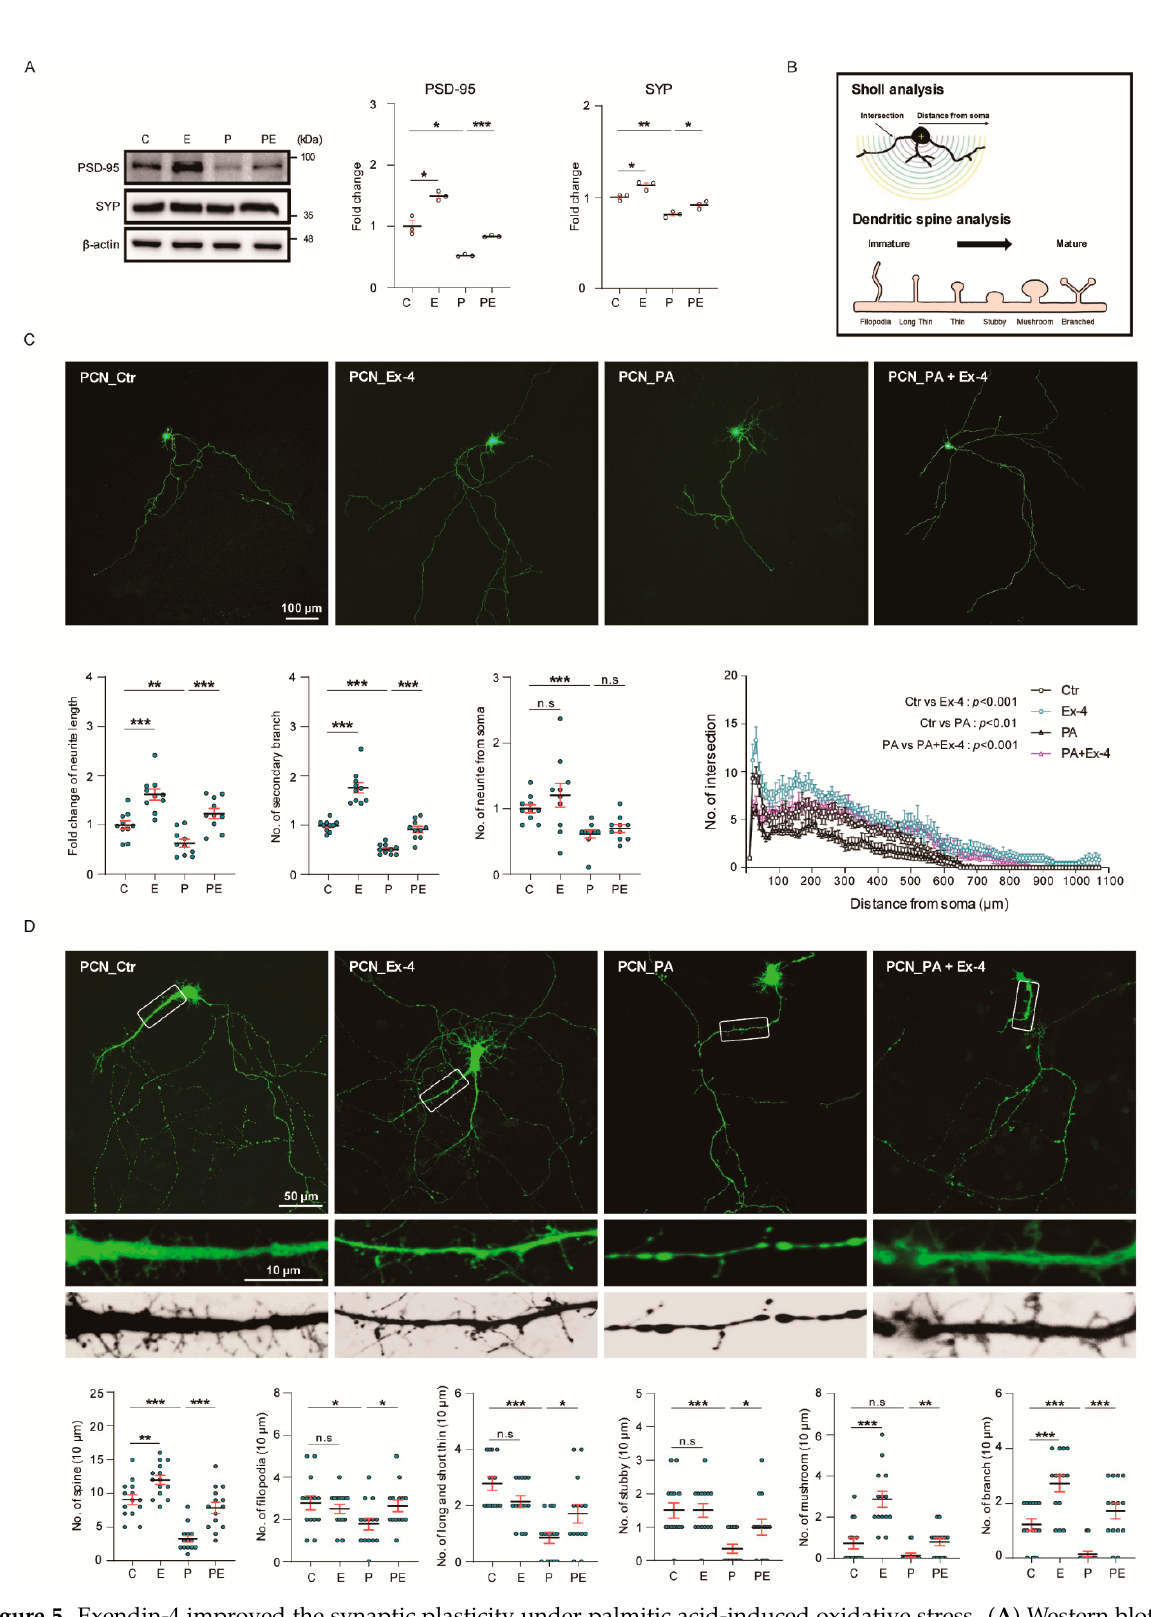
Figure 5. Exendin-4 improved the synaptic plasticity under palmitic acid-induced oxidative stress. ( A ) Western blot of synaptic plasticity-related protein in PCN at DIV21 treated with vehicle (C or Ctr), Exendin-4 (E or Ex-4), palmitic acid (P or PA), and both palmitic acid and Exendin-4 (PE or PA+Ex-4). Each protein level is normalized to β -actin. ( B ) Scheme of Sholl analysis (upper) and dendrite spine morphology analysis (lower). ( C ) Fluorescent images, histograms, and Sholl analysis for neurite complexity of pMax-GFP-transfected PCN neurons at DIV7 treated with reagents described in ( A ). Scale bar: 100 μ m. Neurite length, number of neurites from soma, and Sholl analysis analyzed from >150 cells per group.